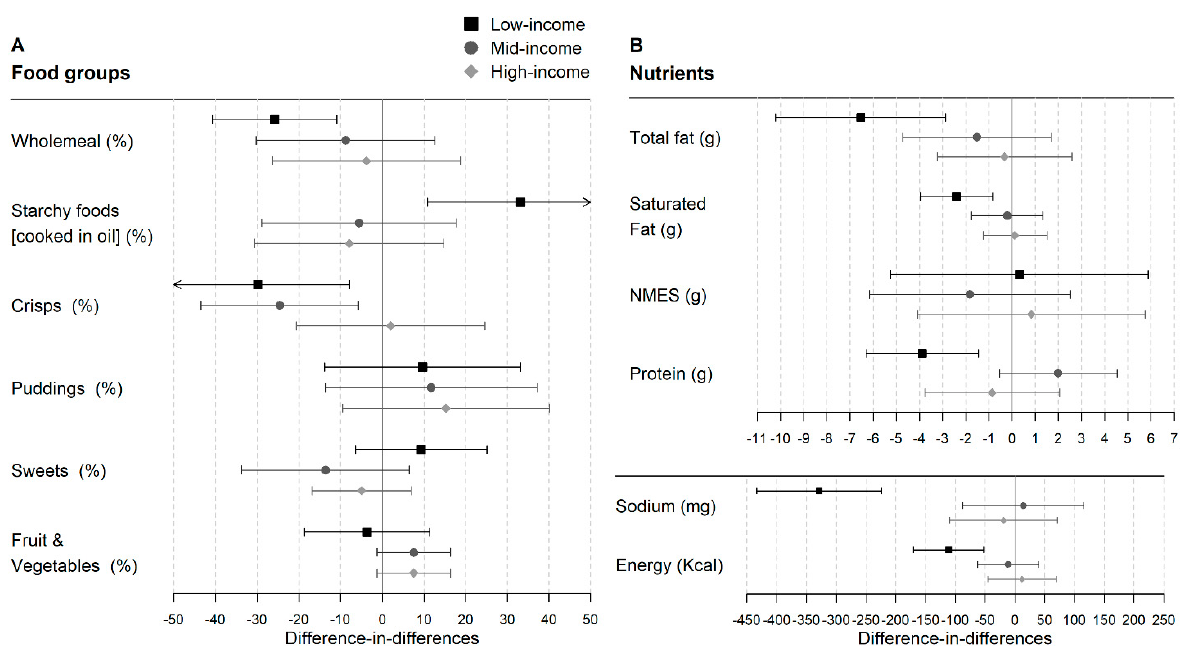
Figure 4. Difference-in-differences estimates of UIFSM policy impact on selected study outcomes, stratified by income level. ( A ) Food group outcomes. Linear probability regression adjusted for age, sex, ethnicity, household size, region, household income, IMD and total lunchtime intake. Coefficients represent percentage point change in likelihood of consuming a food group. Pre/Post intakes presented in Table S12. ( B ) Nutrient outcomes. Linear regression adjusted for age, sex, ethnicity, household size, region, household income, IMD and total lunchtime intake. Pre/Post mean intakes of nutrients presented in Table S13. NMES—non-milk extrinsic sugar.